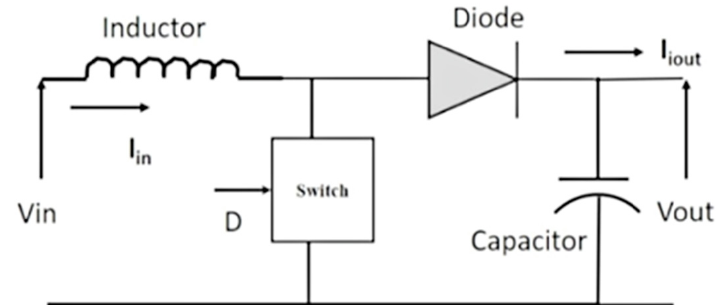
Figure 3. The block diagram of the DC-DC boost converter.